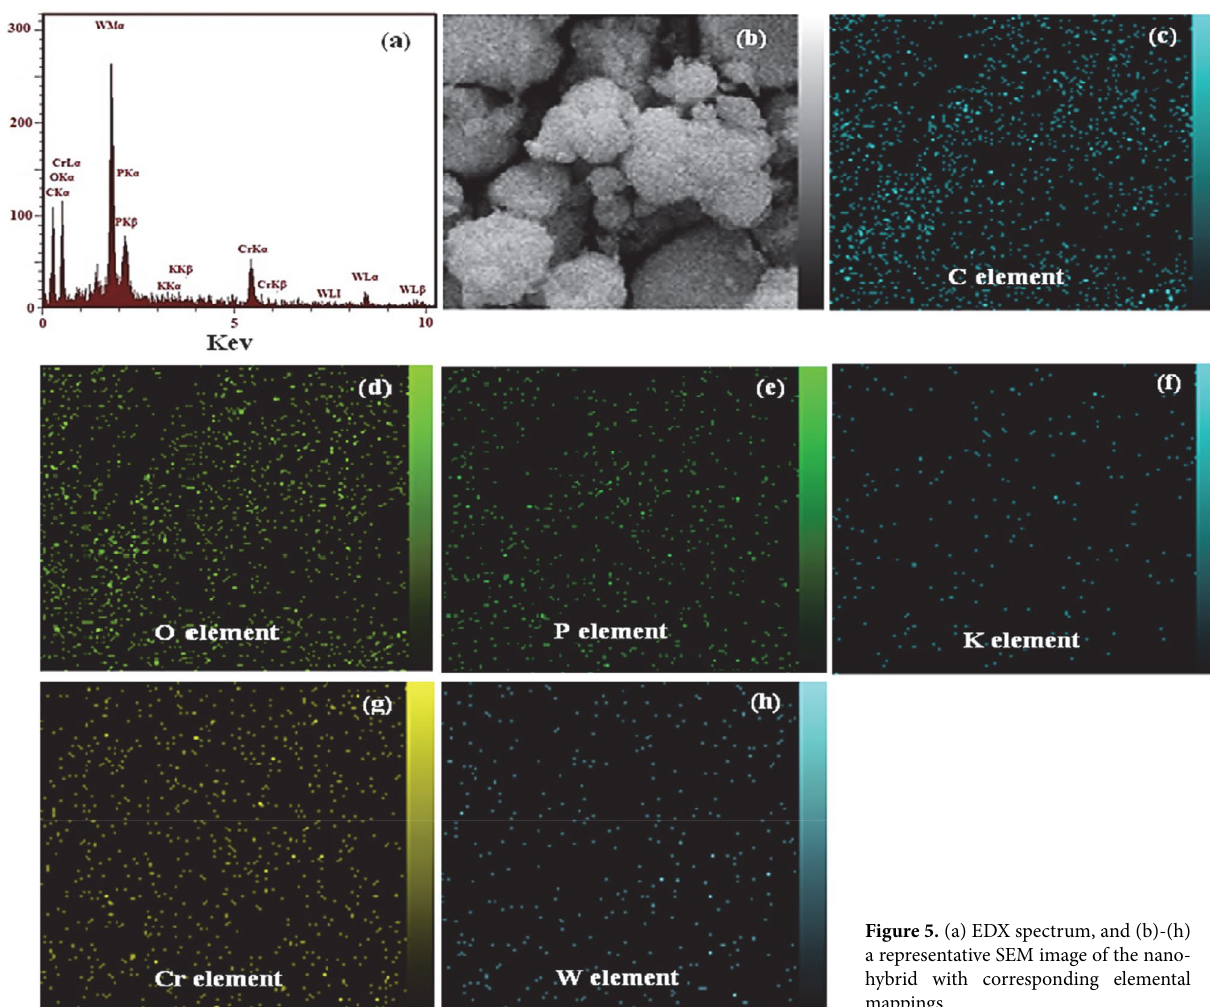
Figure 5. (a) EDX spectrum, and (b)-(h) a representative SEM image of the nano- hybrid with corresponding elemental mappings.